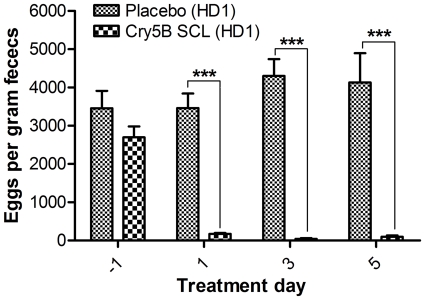
Effects of Cry5B on egg production in Heligmosomoides bakeri infected mice.Shown are the average eggs/gram of feces/mouse for both placebo (n = 10) and Cry5B HD1-(n = 10) treated groups the day before treatment (−1) and then every other day thereafter until the animals were euthanized on day 5 post-treatment.